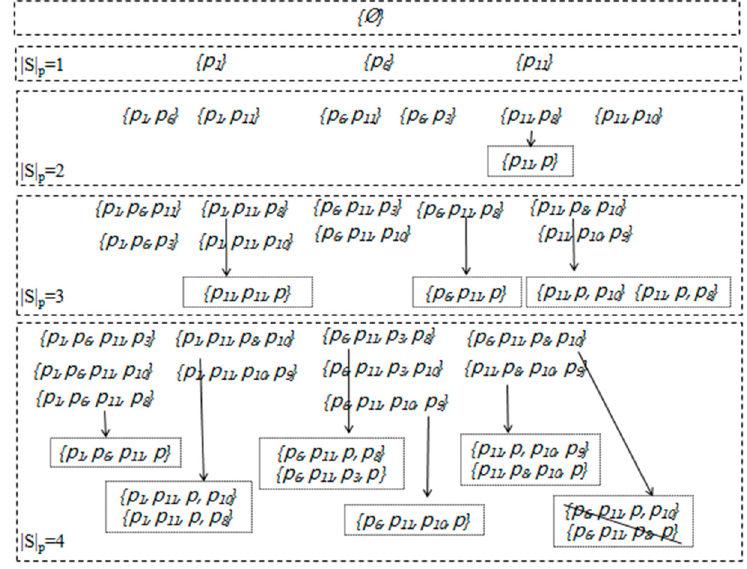
Figure 7. Finding G-Skyline when a new point arrives.